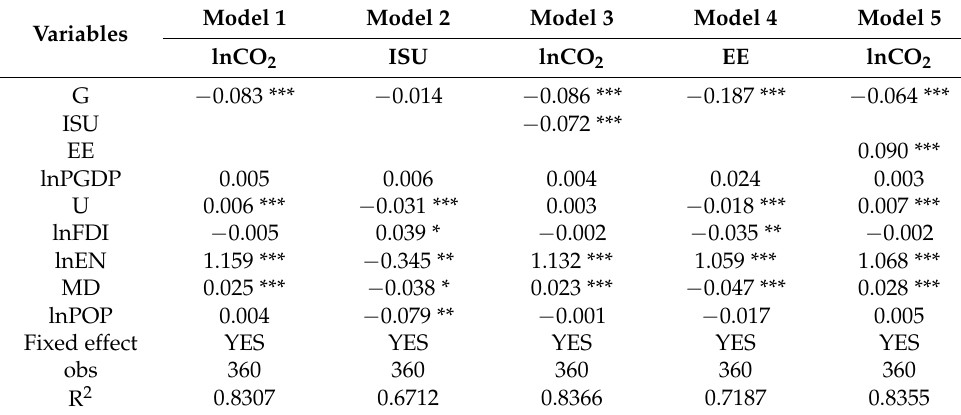
Table 9. Results of the spatial mediation